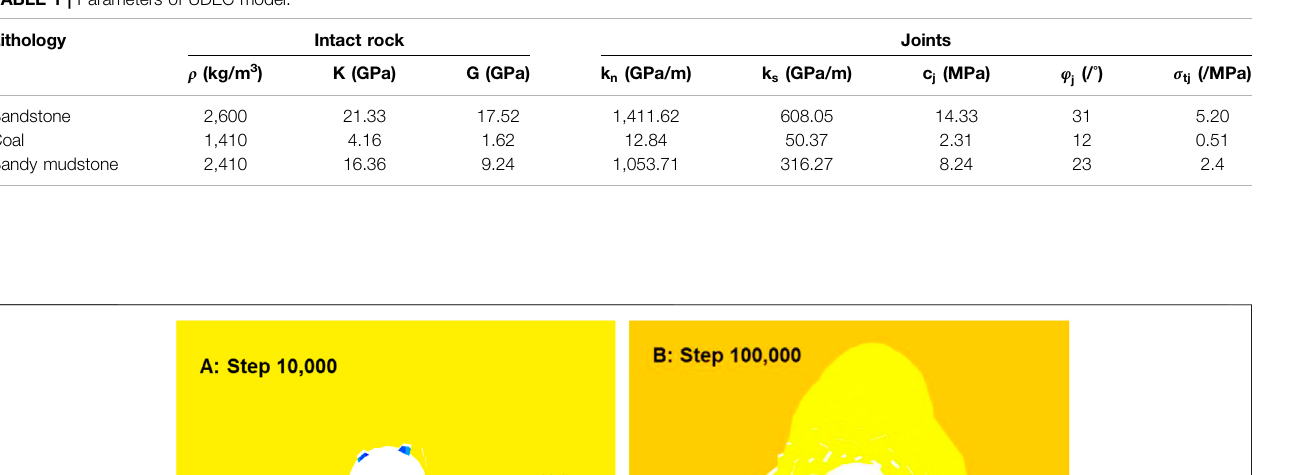
Frontiers in Earth Science |